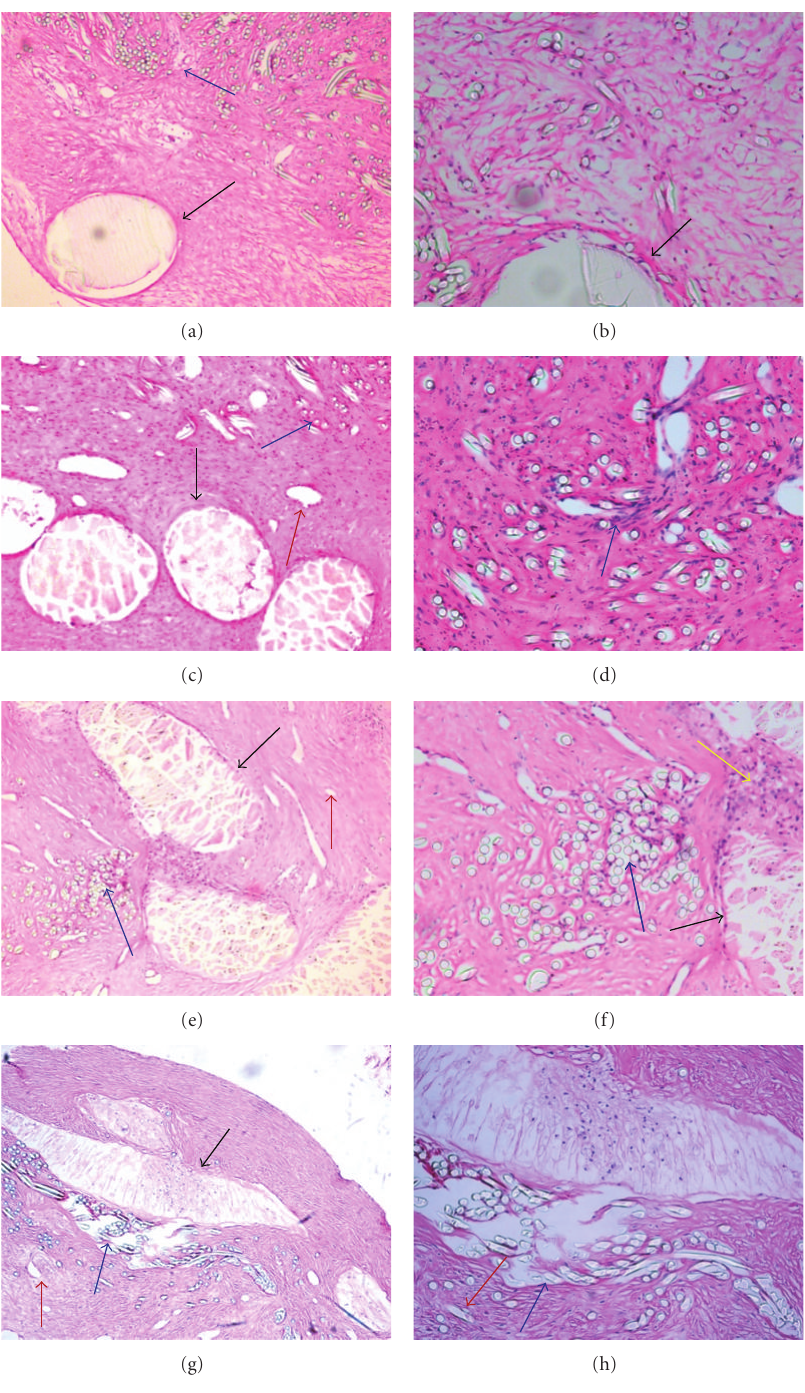
Figure 5: HE staining of occluder at di ff erent time points after procedure (a, c, e, and g original magnification: 10 × 10; b, d, f, and h original magnification 10 × 20). (a, b) At 8 weeks after implantation, PDO (black arrow) and PLA (blue arrow) wire was kept in shape; there were a large number of inflammatory cells around the around PDO wire (black arrow). (c, d) At 12 weeks after implantation, the edge of PDO wire (black arrow) began to disintegrate, and newly formed microvessels could be seen (red arrow); PLA wire (blue arrow) was surrounded by inflammatory cells. (e, f) At 16 weeks after implantation, the majority of the edge of PDO has been disintegrated (black arrow); the inflammation has subsided; well remodeling microvessels could be seen (red arrow); aggregates of multinuclear giant cells (yellow arrow) were found in the areas where the PDO wires had undergone degradation. (g, h) At 24 weeks after implantation, PDO almost completes degradation and substituted by hyperplastic fibrous connective tissue (black arrow), the PLA (blue arrow) that was partly degraded and neovascular could be seen (red